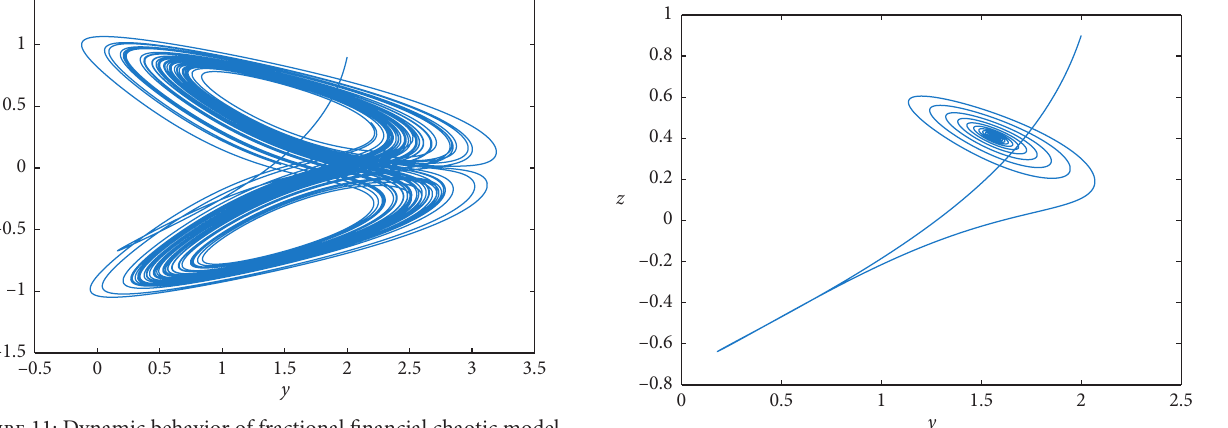
Figure 14: Dynamic behavior of fractional financial chaotic model with α � 0 . 95.